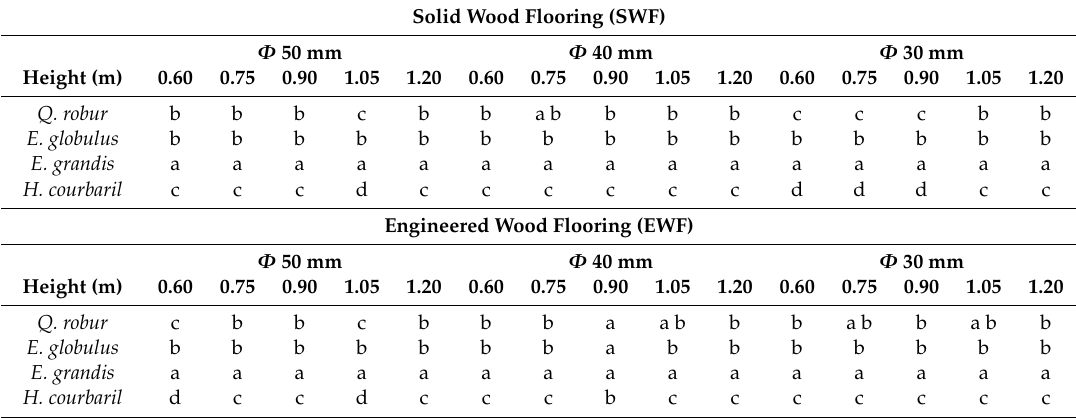
Table 5. FD Pairwise comparison for species per wood flooring types and drop height x Φ ball.